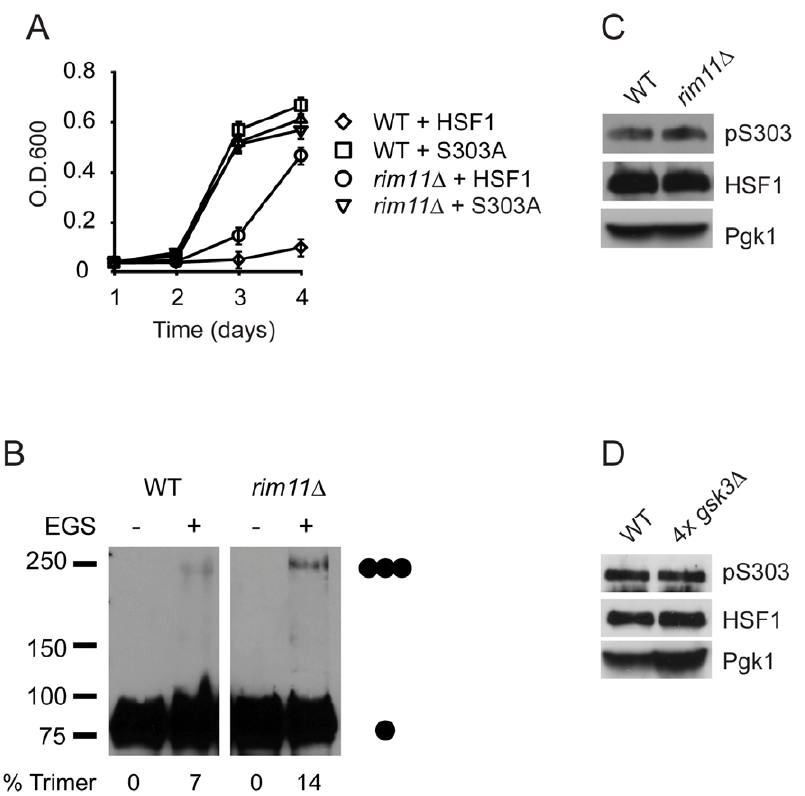
Figure 4. GSK3 represses HSF1 activity in yeast independent of S303. ( A ) PS145 (WT) expressing wild-type HSF1 or the S303A HSF1 mutant and LNY1 ( rim11 D ) expressing wild-type HSF1 were grown in dextrose supplemented medium for 4 d. Growth was monitored by measuring O.D. 600 . ( B ) PS145 (WT) and LNY1 ( rim11 D ) expressing wild-type HSF1 were grown on galactose containing medium and were evaluated for HSF1 multimerization by EGS crosslinking, SDS-PAGE, and immunoblotting using an HSF1 specific antibody. The positions of molecular weight markers are indicated on the left, and circles indicating the expected migration of HSF1 monomers and trimers are on the right. Levels of HSF1 trimer as percent of total HSF1 are shown below. ( C ) PS145 (WT) and LNY1 ( rim11 D ) were transformed with a plasmid expressing wild-type HSF1 and were grown on galactose containing medium. Total protein extracts were analyzed for pS303, total HSF1 and Pgk1 by immunoblotting. ( D ) YPH499 (WT) and LNY3 (4x gsk3 D ) were transformed with a plasmid expressing wild-type HSF1 and were grown in dextrose containing medium. Total protein extracts were analyzed for pS303, total HSF1 and Pgk1 by immunoblotting.